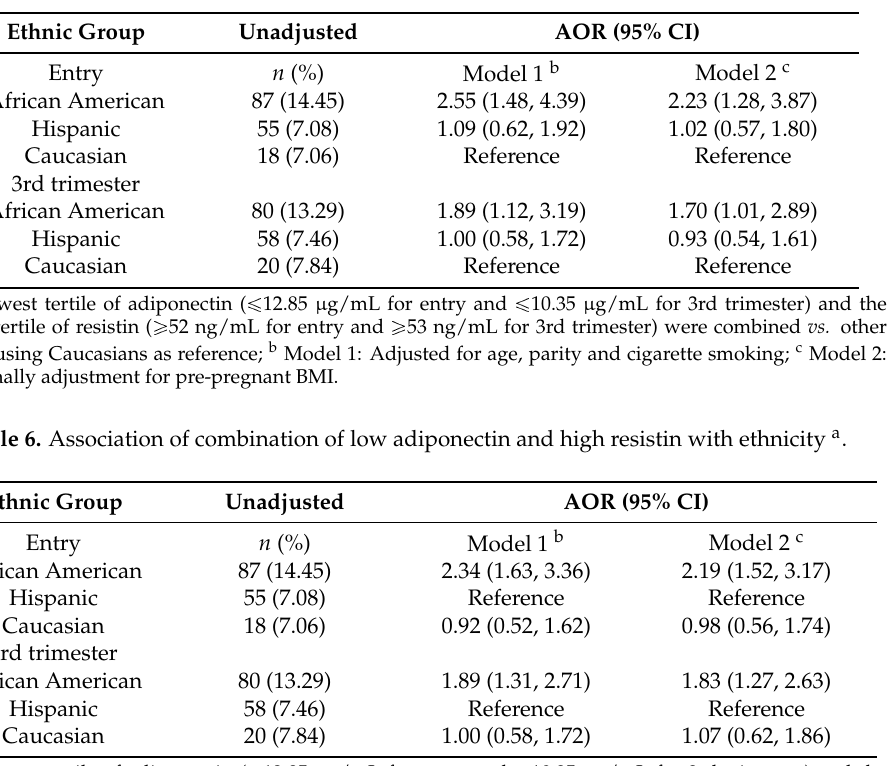
Table 5. Association of combination of low adiponectin and high resistin with ethnicity a .